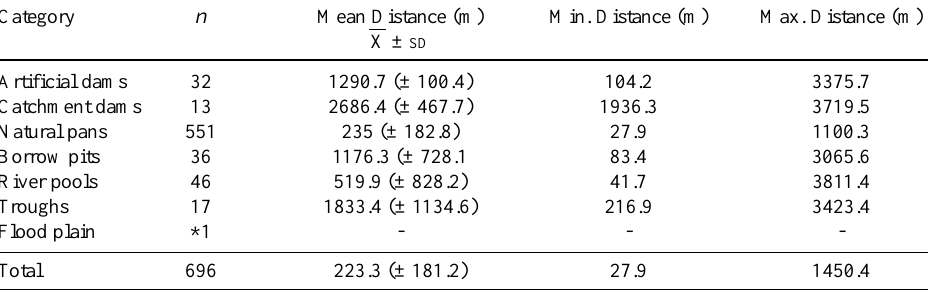
The total number and distances between water source sites according to seven water sources categories on the Manyeleti Game